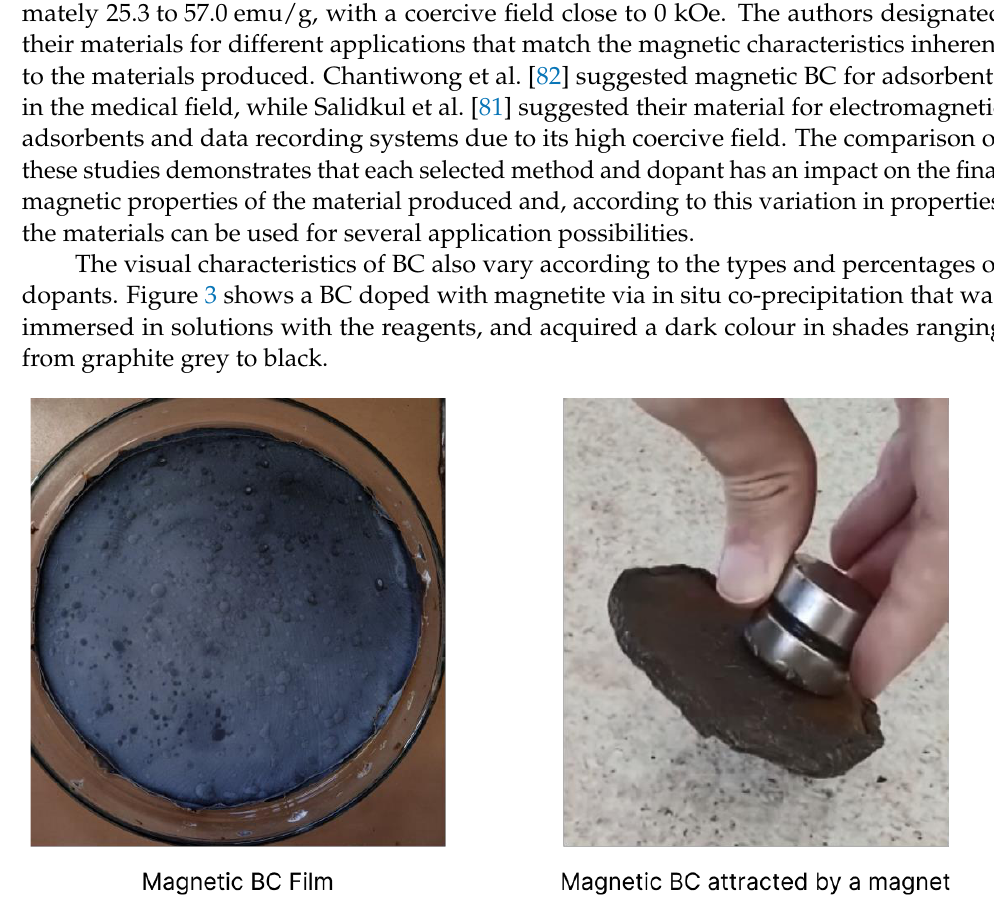
Table 3. Magnetic materials added to BC and respective applications.